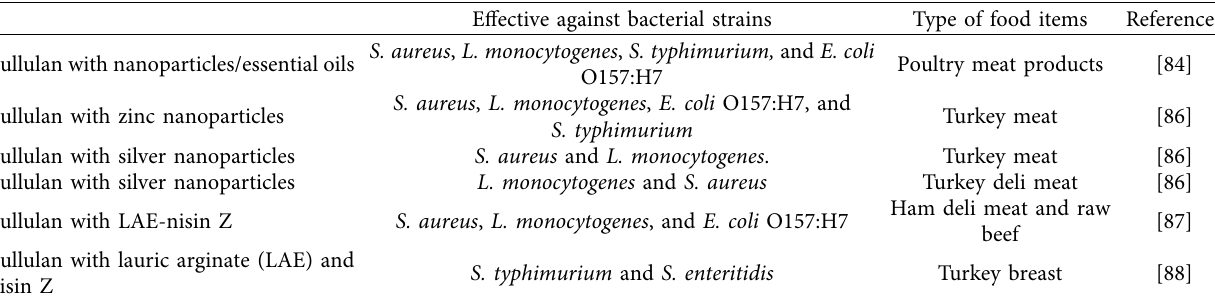
Table 4: Pullulan active packaging for meat